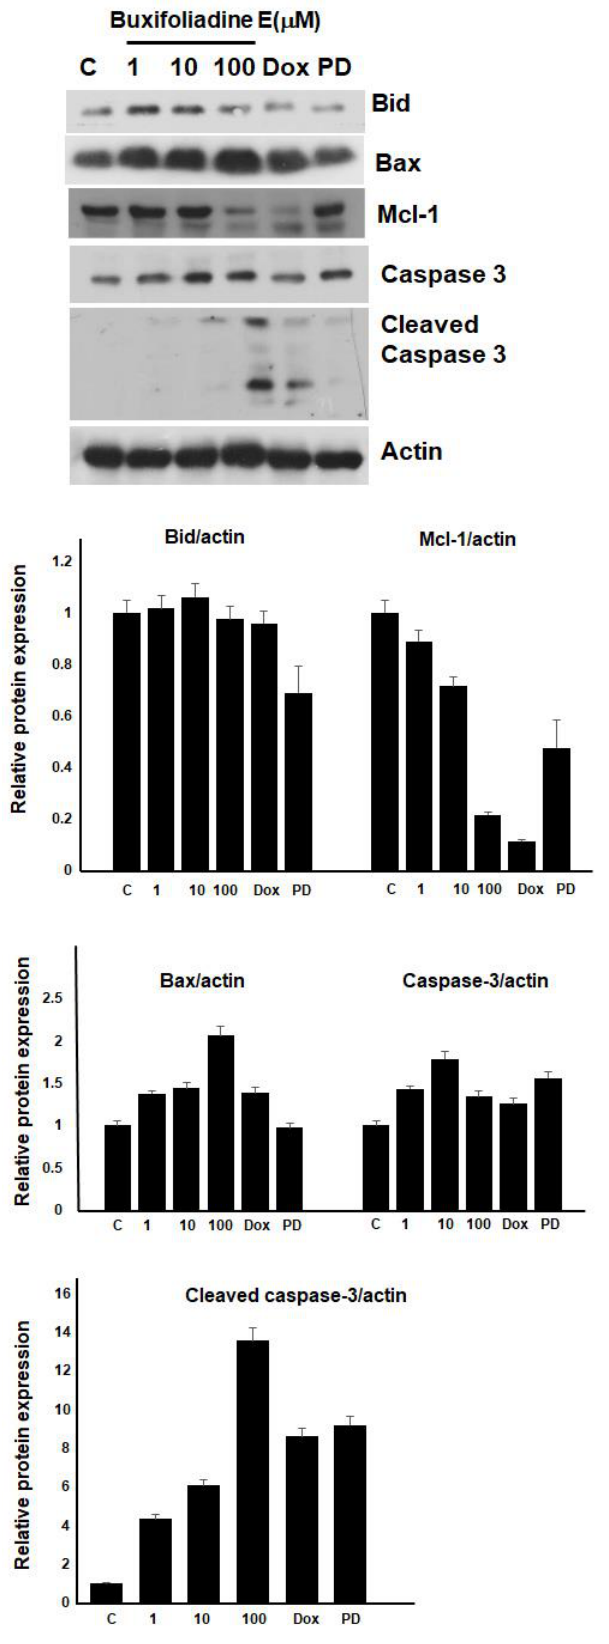
Figure 8. Buxifoliadine E induces apoptosis of HepG2 cells.